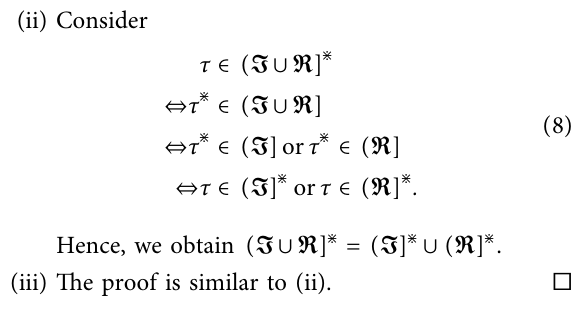
Figure 1: Figure of Θ for Example 1.